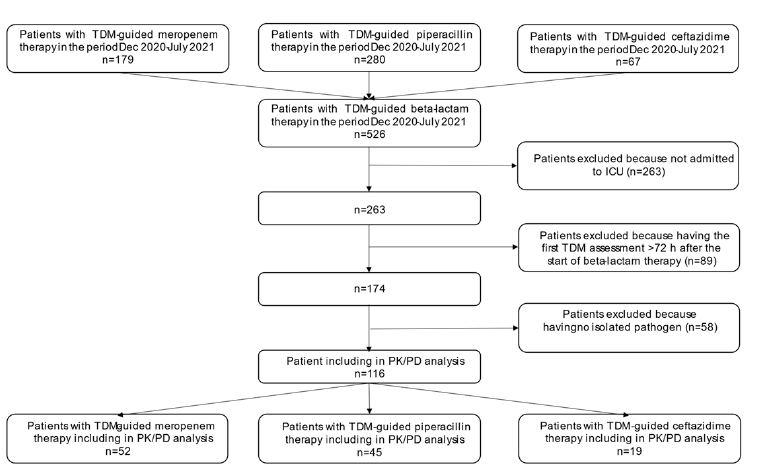
Figure 1. Flowchart of patient inclusion and exclusion criteria. ICU; intensive care unit; PK/PD: pharmacokinetic/pharmacodynamic; TDM: therapeutic drug monitoring.